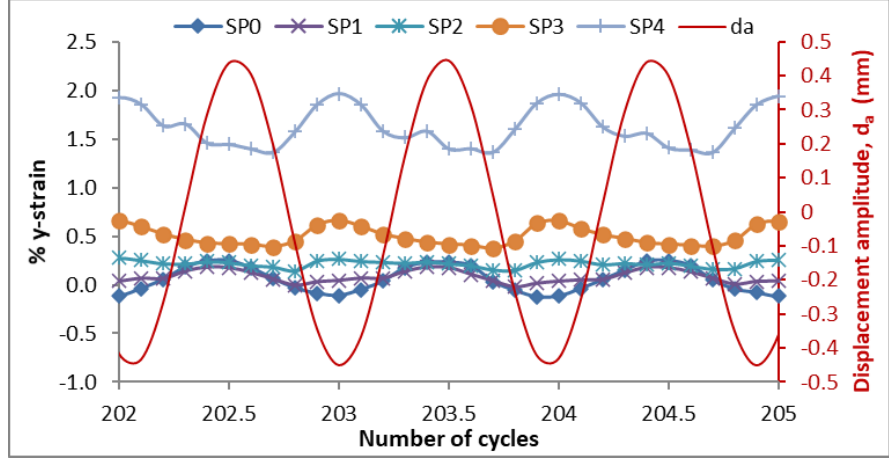
Figure 12. Longitudinal strain after 200 cycles; (d a = 0,45 mm).